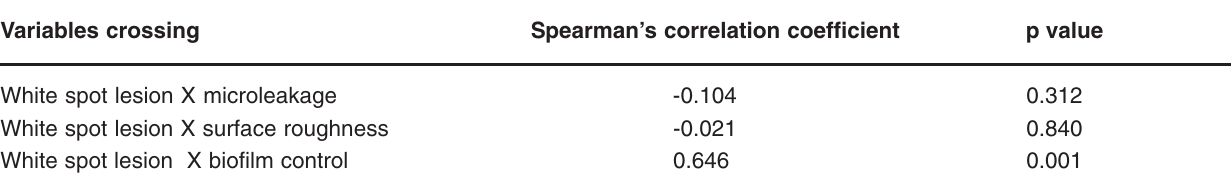
TABLE 3- Correlation between the variables studied and white spot lesion formation Variables crossing